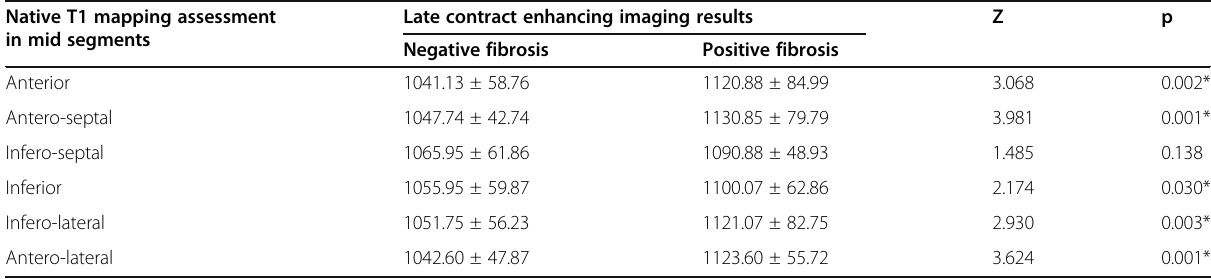
Table 3 Comparison of mean value of native T1 mapping to late contrast enhanced imaging for fibrosis assessment in mid